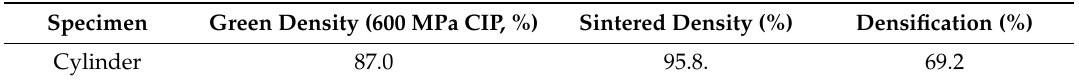
Figure 9. Relative sintered densities of compacts after removing contaminated scale. Table 2. Densities and densification level for large cylinder prepared for tensile testing. CIP: Cold isostatic pressing.